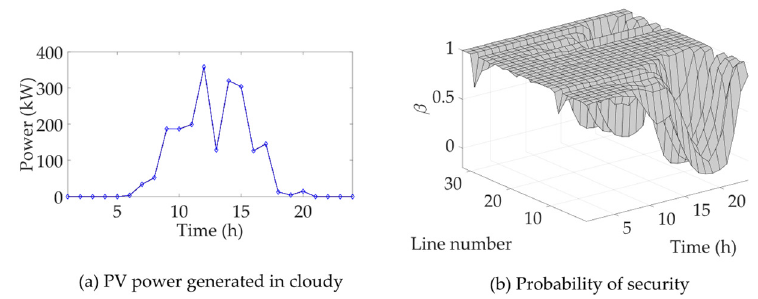
Figure 8. PV power generated and security probability during cloudy weather.